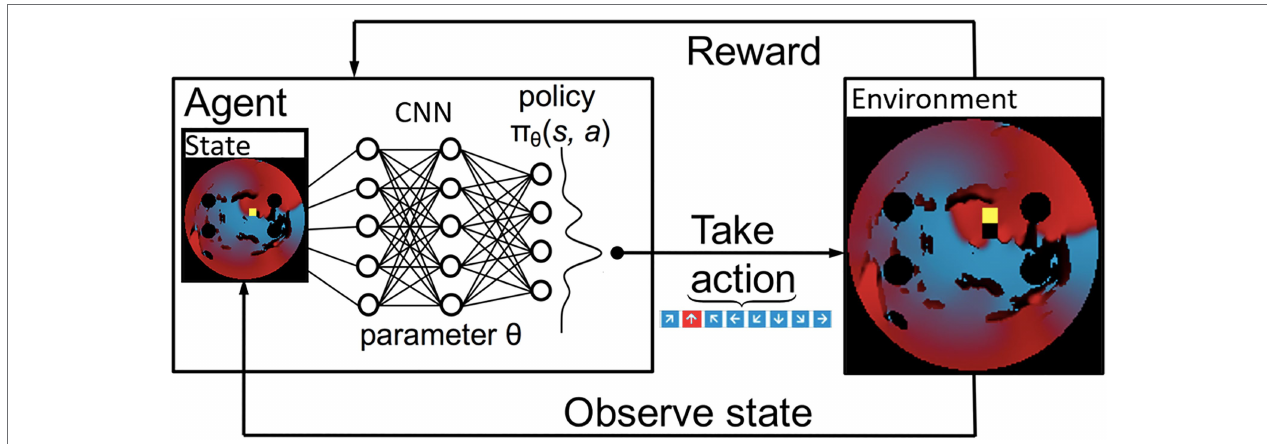
FIGURE 3 | A schematic overview of how a deep Q-Learning network functions. Initially a state is observed, which is then passed through a CNN. The output of this network maps to the predicted Q values of all eight actions available. From here the action is chosen via a ɛ -greedy action selection policy. One notable addition to the implementation used in this paper is there are two copies of the network to ensure